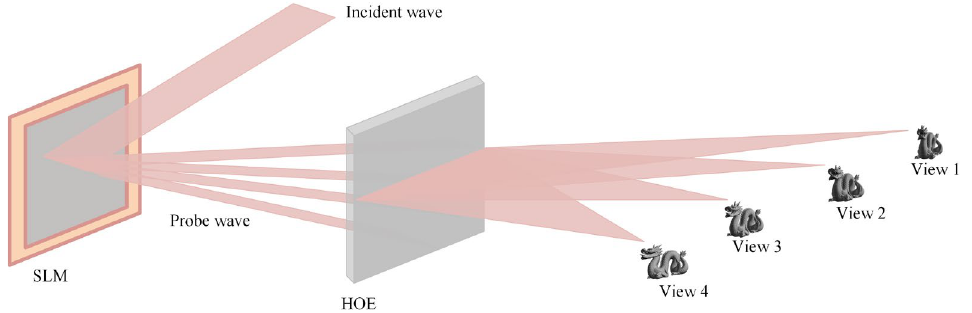
Figure 1. The schematic of the multiview holographic 3D display.